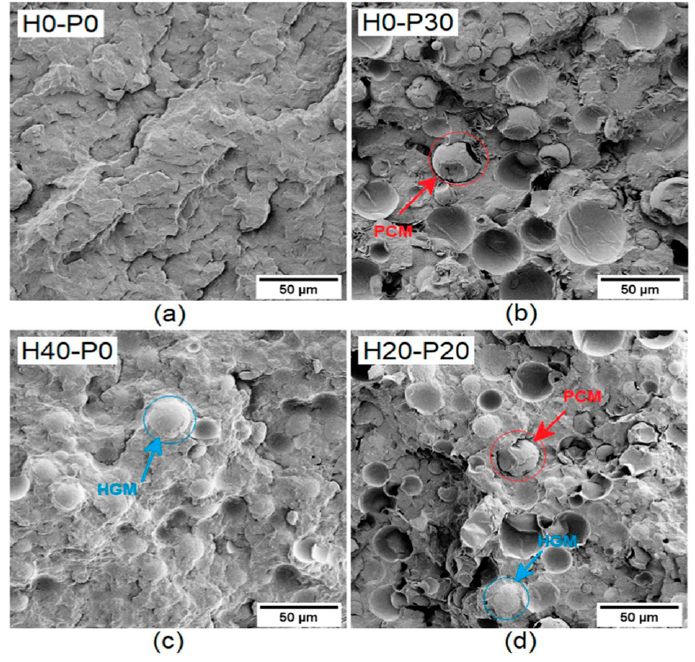
Figure 3. SEM images of fractured surfaces of four compositions studied. ( a ) PP only, zero void content; ( b ) PP & PCM mixture; ( c ) PP & HGM mixture; ( d ) 57%PP/20%HGM/20% PCM & 3% compatibilizer [50].